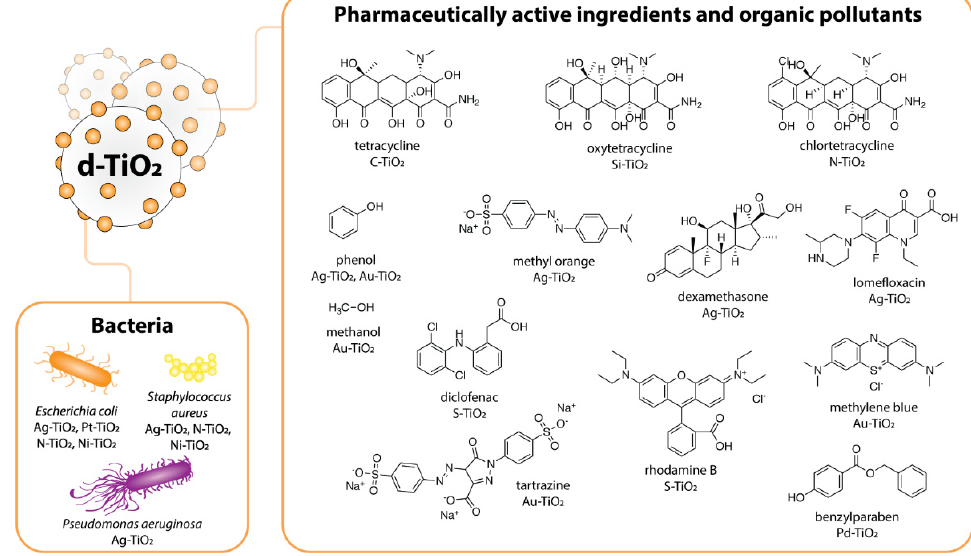
Figure 8. The applicability of single-doped titania composites as catalysts in the photodegradation studies of chemical and pharmaceutical pollutants and bacteria; d-TiO 2 —doped titanium(IV) oxide. Carbon-doped TiO 2 nanophotocatalysts were prepared by Ma et al. from TiO 2 ,